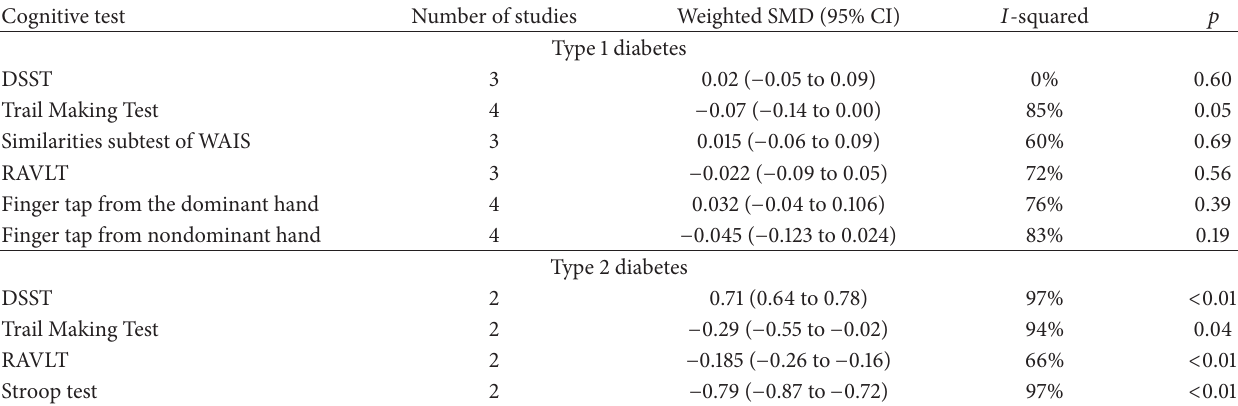
Table 4: Results of weighted SMDs for each cognitive